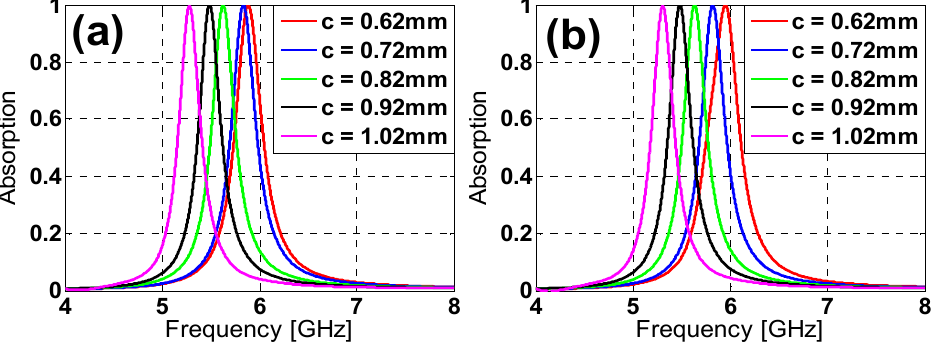
Figure 7. Star design absorption results in the simulation for different lengths of h for both ( a ) TE and ( b ) TM polarizations.